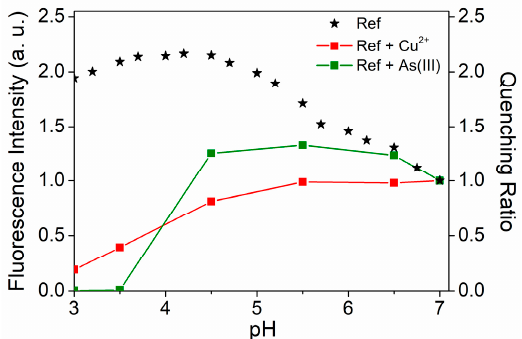
Figure 7. The fluorescence intensity F 0 of the UFQD reference solution (black stars) and the fluorescence response F 0 /F in the presence of Cu 2+ (red squares) and As(III) (green squares) at a concentration of 100 μ M as a function of pH. All the data are normalized at the values at pH 7.